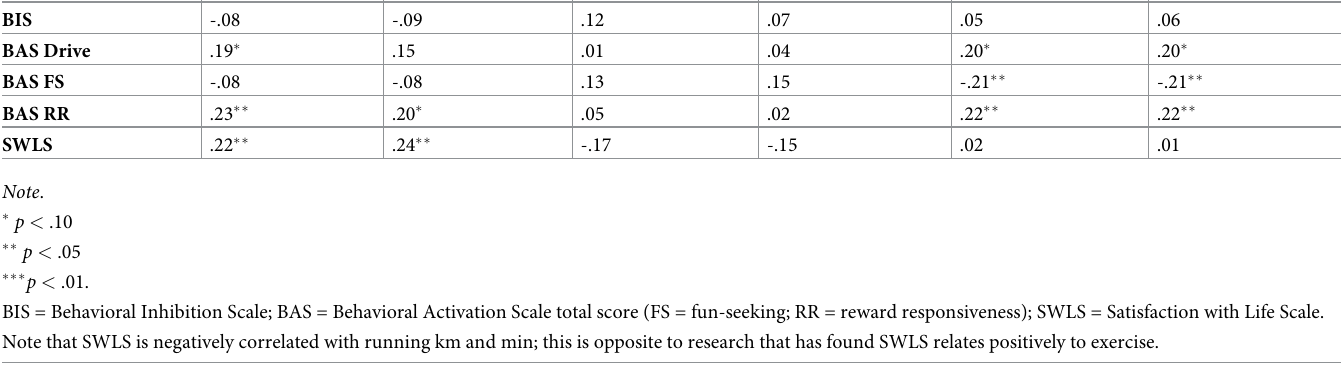
Table 4. Correlations of BIS/BAS and SWLS with exercise variables (controlling for age and gender) (Study 1). Cyc km Cyc min Run km Run